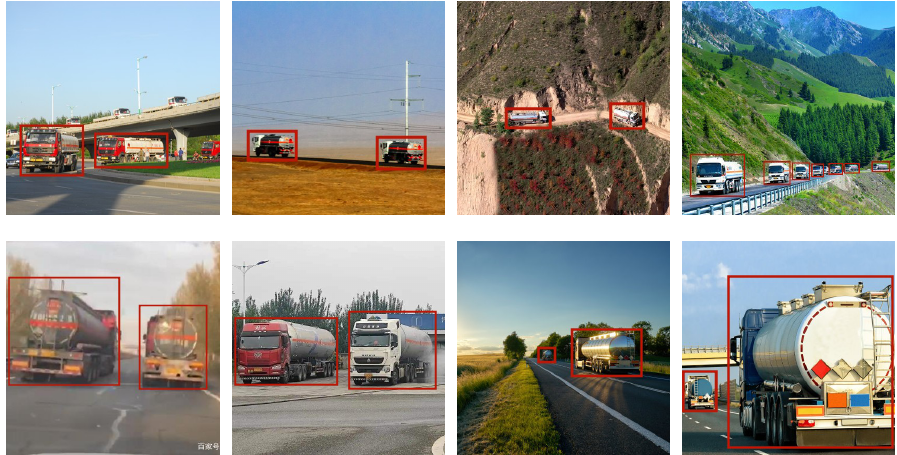
Figure 12. A subset of multi-hazardous material vehicle detection results.